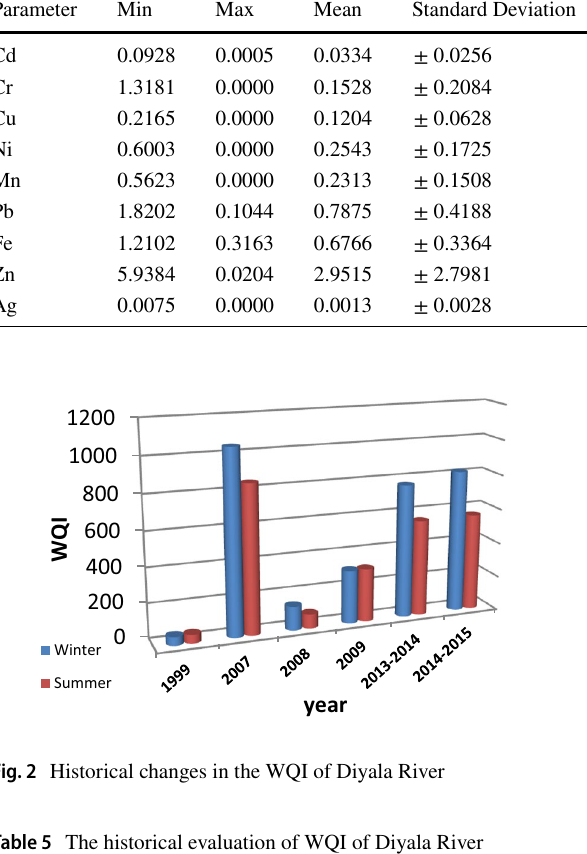
Table 4 Statistical summary of Diyala River’s heavy metals Parameter